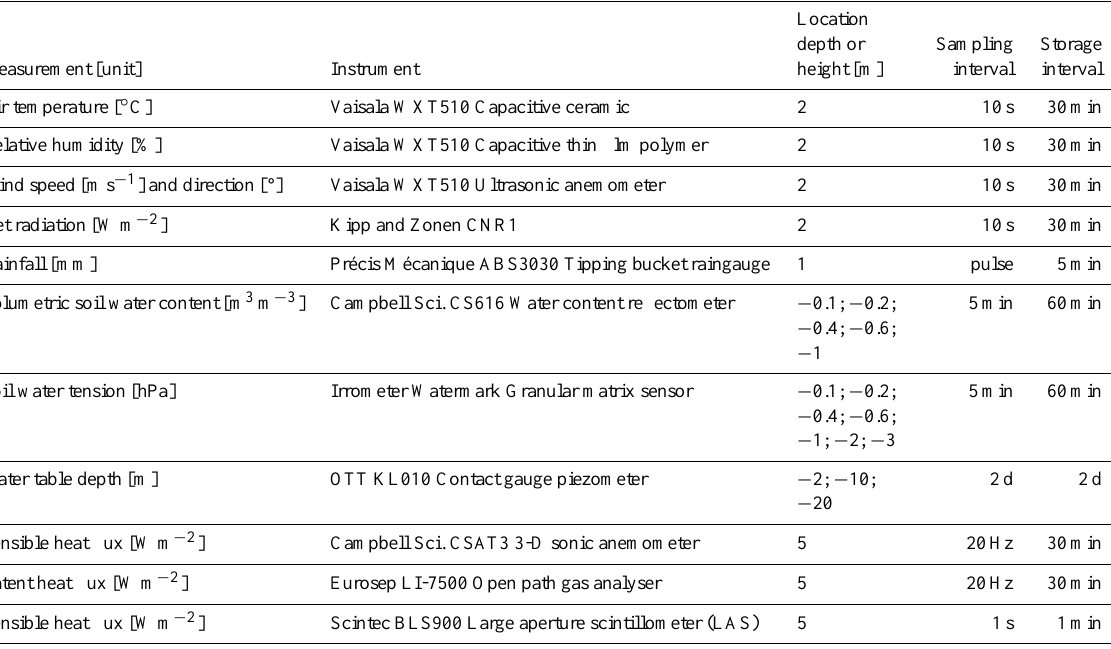
Table 1. Characteristics of measurements, instruments, locations sampling intervals and storage